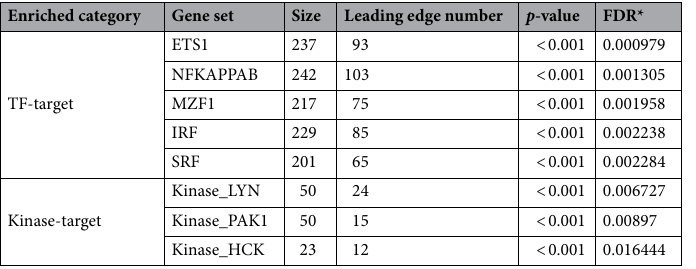
Table 3. Targets transcription factor and kinase of RUNX1 gene in KIRC from Linkedomics. TF transcription factor, FDR false discovery rate, *: FDR <